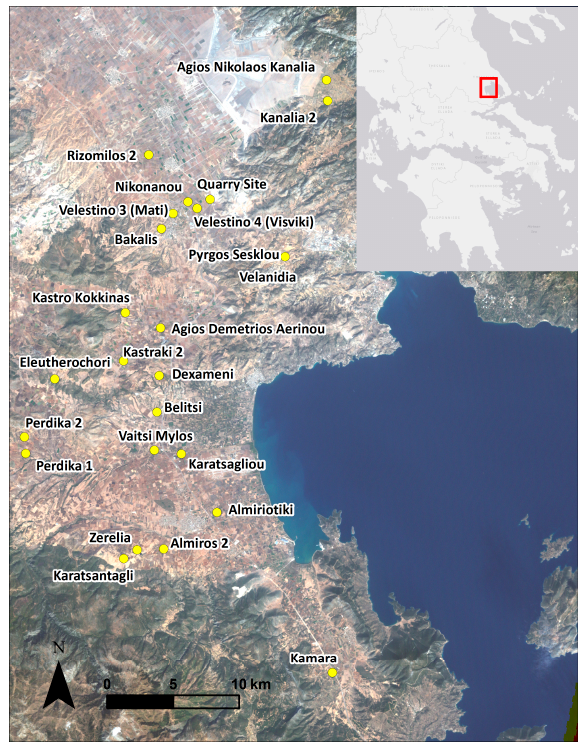
Figure 1. Thessaly was the gateway for the Neolithization of Europe. The Innovative Geophysical Approaches for the Study of Early Agricultural Villages of Neolithic Thessaly (IGEAN) project examined 24 settlements in detail using geospatial technologies. Three sites (Almyriotiki, Perdika 1, and Velestino-Mati) constitute the demonstration case studies of this paper.